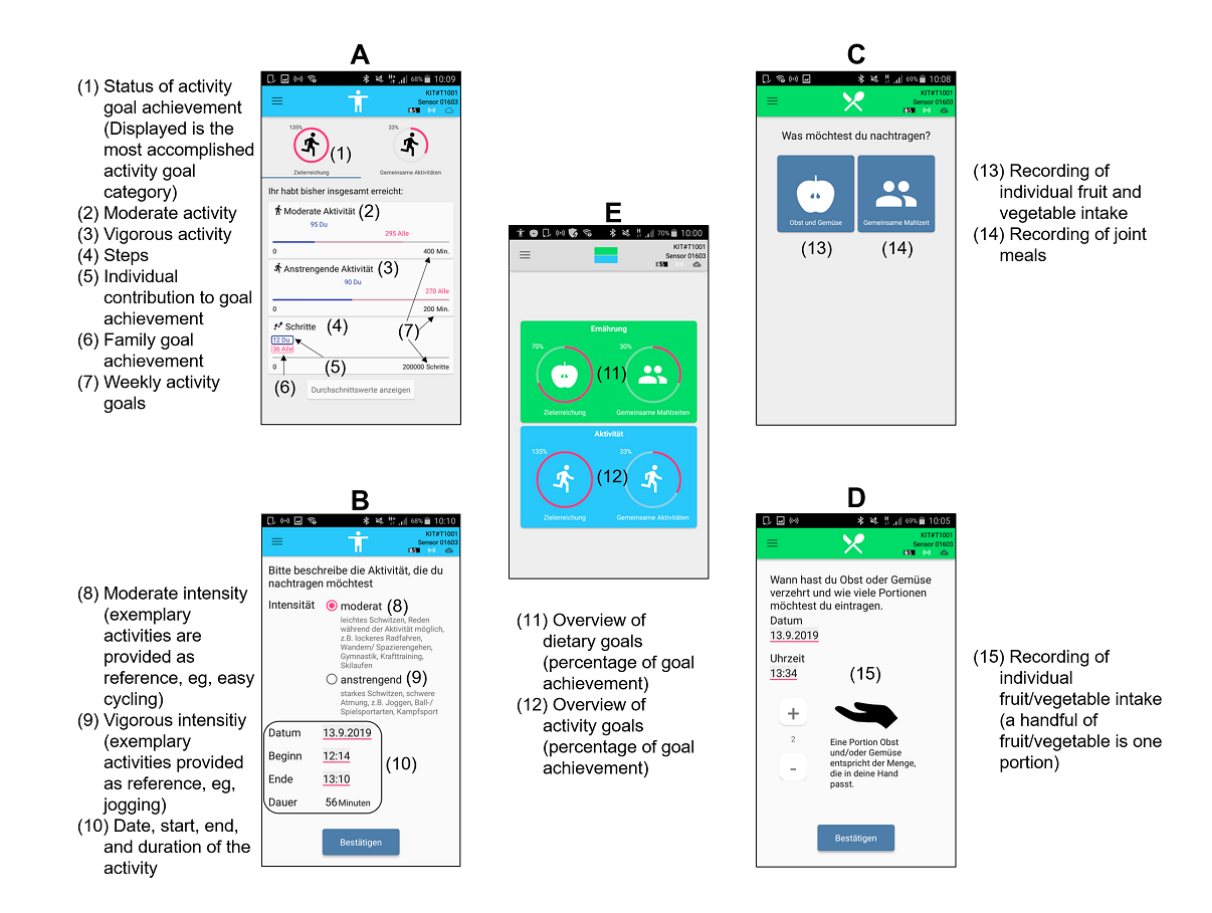
Figure 4. Examples of SMARTFAMILY app screens. A. Detailed status of activity goal achievement; B. Manual activity recording; C. Food recordings; D. Manual food recording; E. Start screen with overview of goal